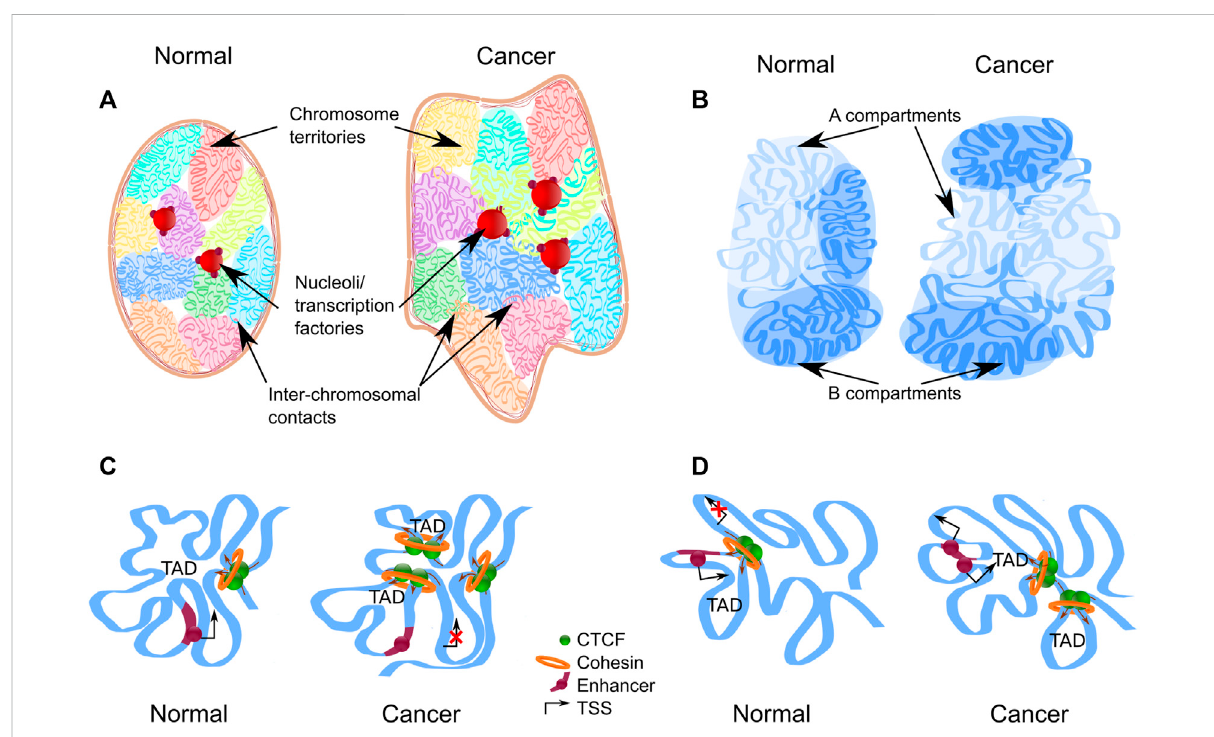
FIGURE 1 Levels of chromatin architecture organization in normal and cancer cells. (A) Chromosome territories change location in the nucleus of a cancer cell. Some chromatin regions can be up-regulated as a result of moving from the silent environment of lamina-associated domains to a nuclear interior. Entanglement between some chromosomes increases in the nucleus of a cancer cell. Chromosome territories repositioning and intermingling can facilitate certain translocation formation. (B) Compartment switching is in cancer cells, which is followed by expression alteration. Long-range interactions between different types of compartments are increased in cancer cells. (C,D) Topologically associating domains (TADs) reorganize in cancer cells. The appearance of new TAD may destroy the regulation of oncogenes or tumor-suppressor genes (C) . Fusion of TADs in different epigenetic states could lead to the formation of new regulatory landscape and upregulation of repressed genes (D)